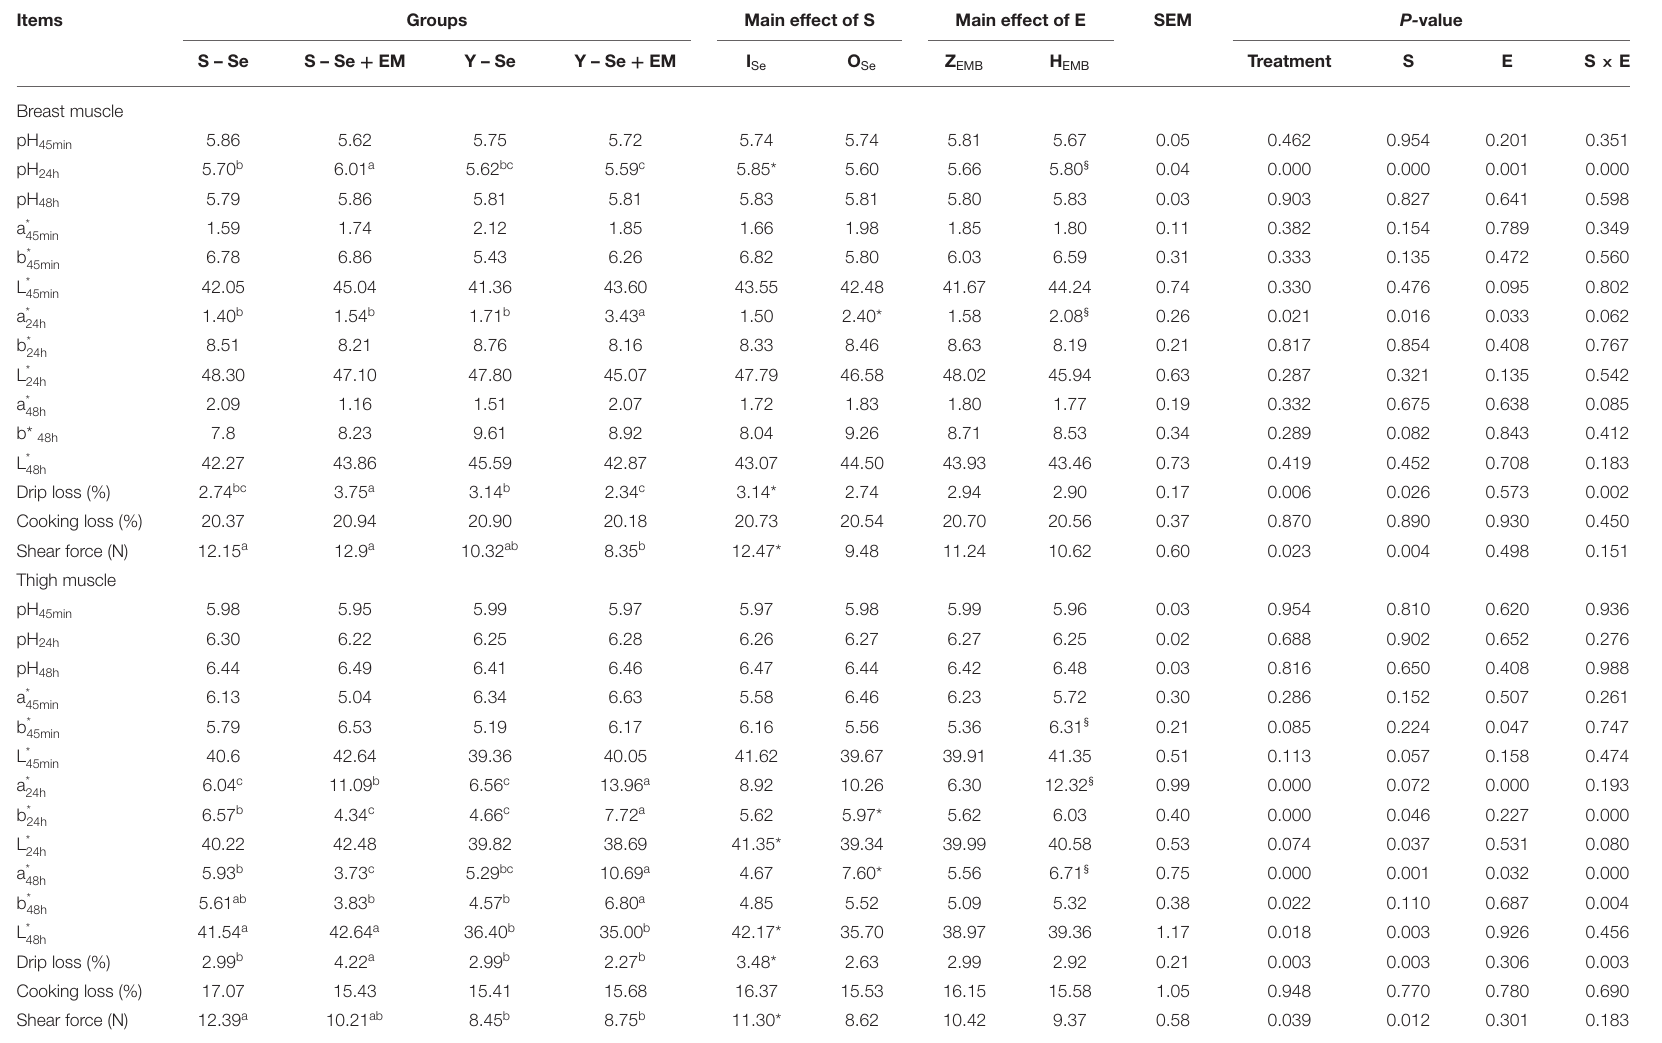
TABLE 5 | Effects of different Se sources and different bacteria supplementation levels on the meat quality of three-yellow chickens.